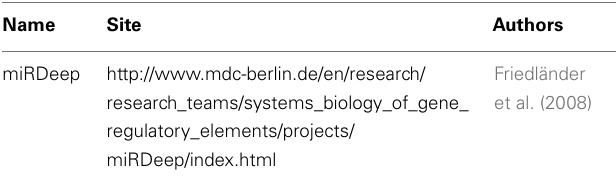
Table 6 | miRNA gene discovery for HTS.